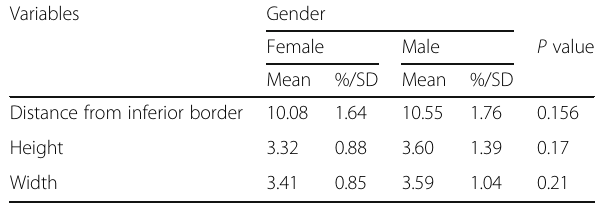
Table 4 Properties of mental